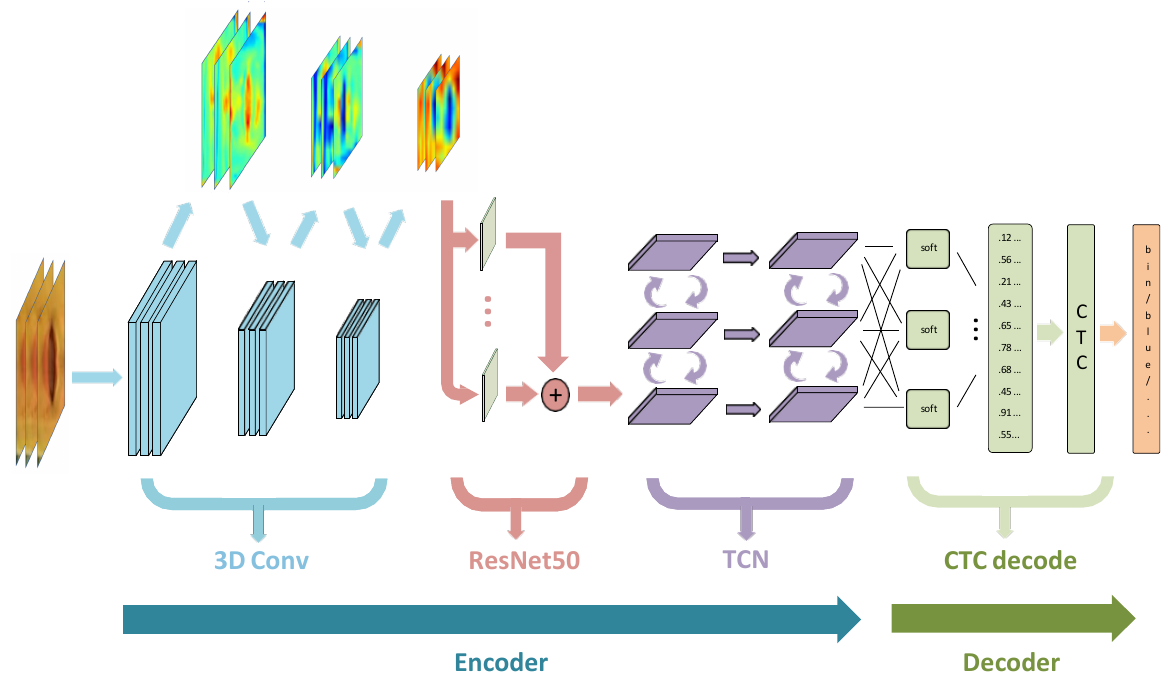
Figure 2. The proposed architecture. A lipreading video containing N frames as input is followed by one layer of 3D-CNN, followed by a 3D average pooling layer. The 3D feature maps are passed through a residual network (ResNet50, [37]). The classification and fusion of feature maps are processed by the 2-layer TCN [36] network; and the TCN output of each time-step is processed by the linear layer and the softmax activation function. This end-to-end sentence-level lipreading architecture is trained using the CTC objective